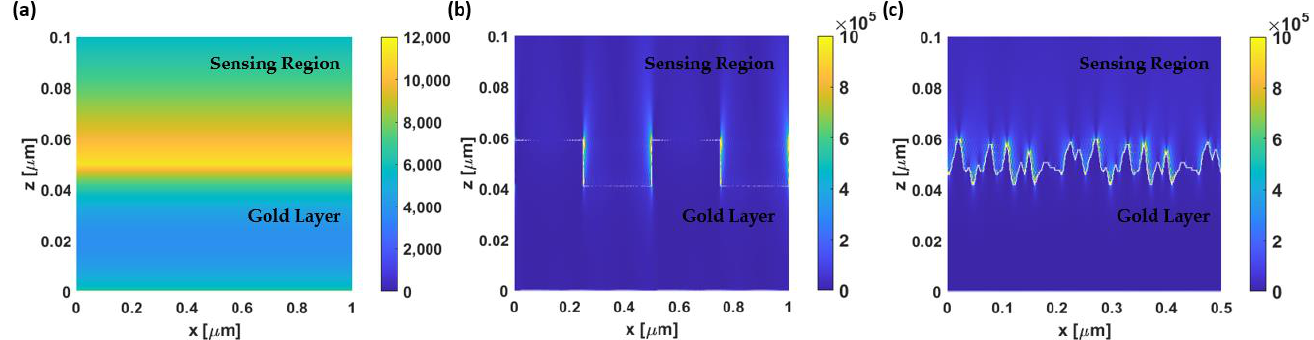
Figure 15. The plots of the total electric field intensity in the SI unit in the x-direction and z-direction (|E x | 2 + |E z | 2 ) on the gold-based SPR sensor with ( a ) an ideal smooth surface; ( b ) gratings structure with a gratings’ height of 24 nm, a gratings’ period of 500 nm, and a fill factor of 0.5 ; and ( c ) a rough sensing surface with h and cl of 9 nm and 8 nm, respectively (operating point ‘d’).